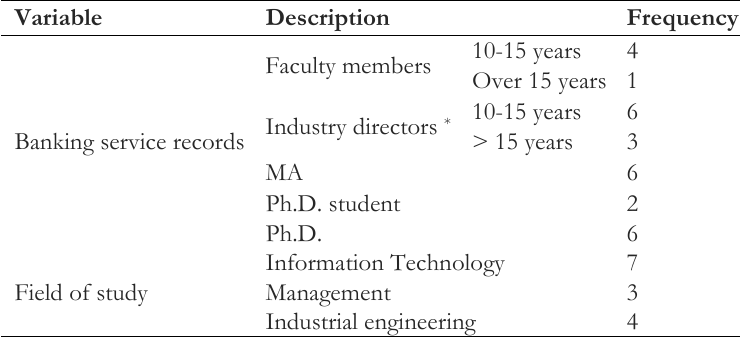
Table 2 shows the participants’ demographic data . Table 2. The participants’ demographic data.